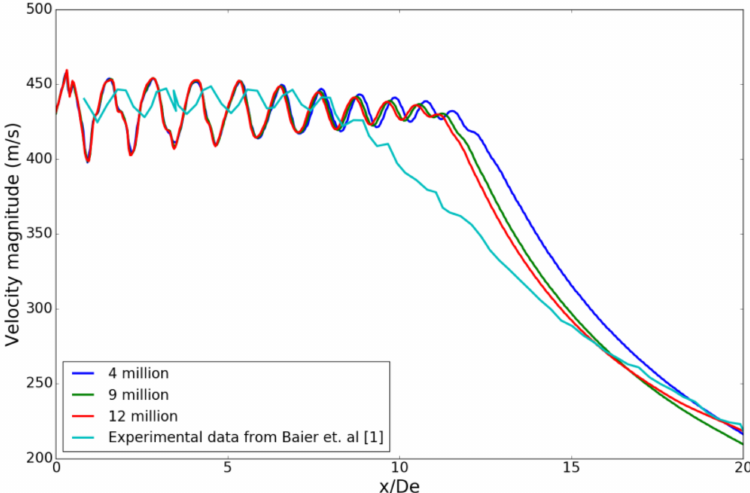
Figure 2. Grid resolution